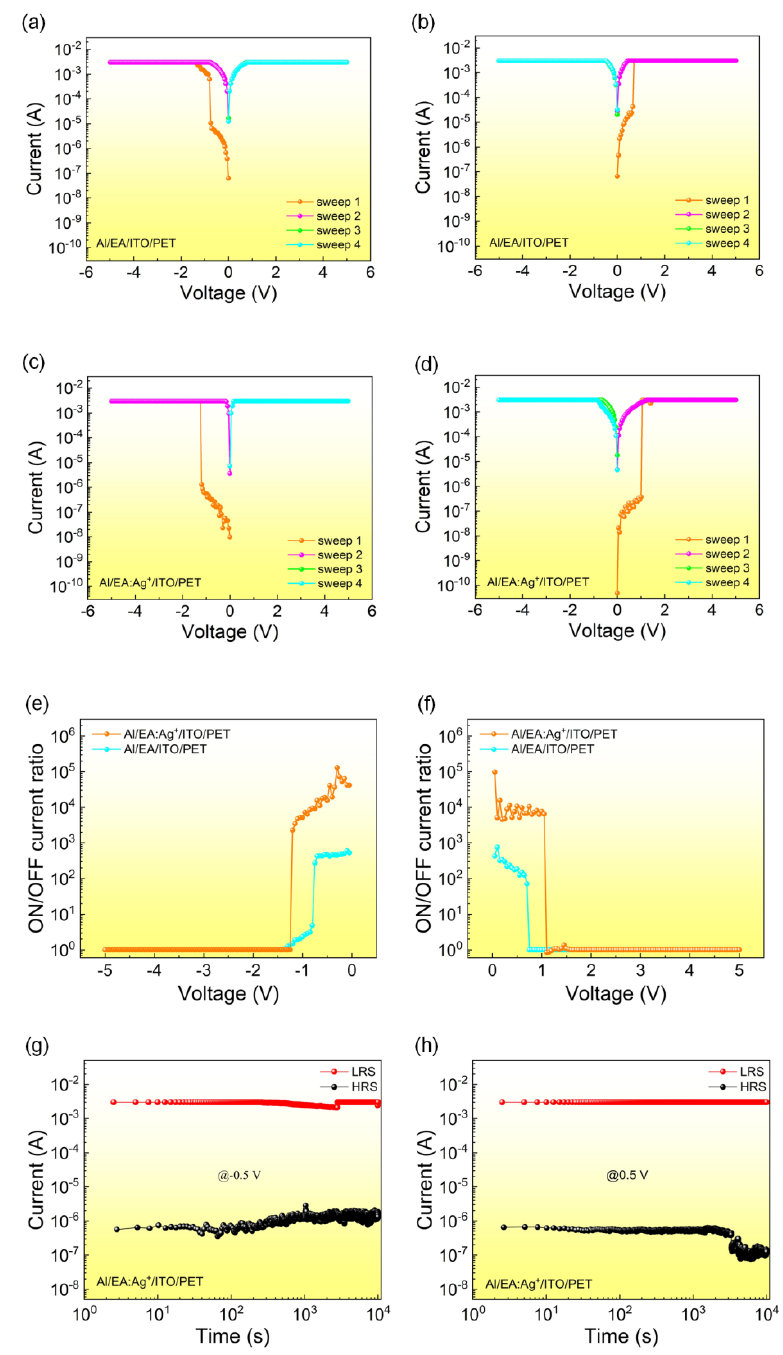
Figure 2. Current–voltage characteristic curve of the Al/EA/ITO device: ( a ) initial application of negative voltage and ( b ) initial application of positive voltage. I–V characteristic curve of the Al/EA:Ag + /ITO device: ( c ) initial application of negative voltage and ( d ) initial application of positive voltage. ON/OFF current ratio of the Al/EA:Ag + /ITO device: ( e ) initial application of negative voltage and ( f ) initial application of positive voltage. Retention time of the Al/EA:Ag + /ITO device: ( g ) initial application of negative voltage (read voltage is −0.5 V) and ( h ) initial application of positive voltage (read voltage is 0.5 V).